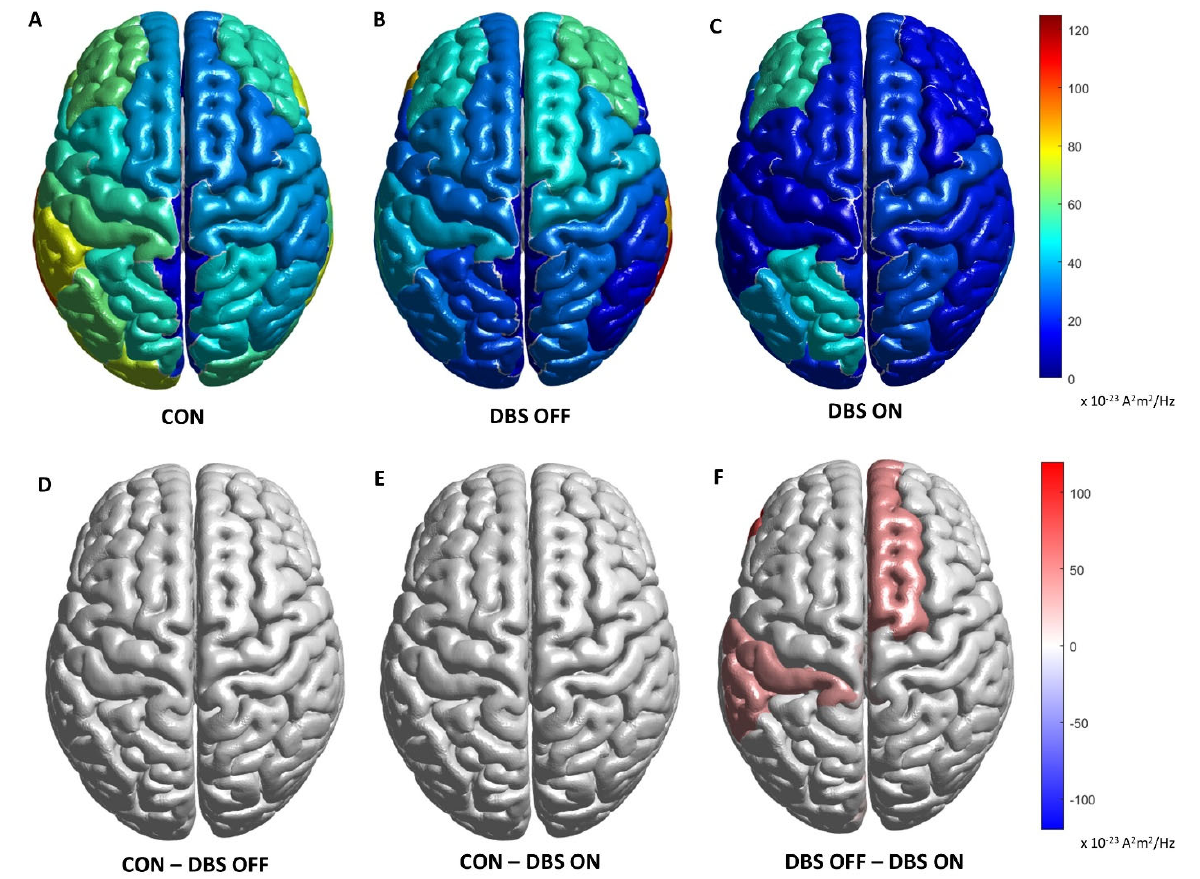
Figure 1. First row shows magnitude of power spectral density for each ROI, respectively, in controls ( A ) and in PD patients with DBS ‐ OFF ( B ) and DBS ‐ ON ( C ) states in β frequency bands. Second row reports differences in magnitudes of power spectral density between controls and PD DBS ‐ OFF ( D ), controls and PD DBS ‐ ON ( E ) and DBS ‐ OFF and DBS ‐ ON states ( F ) in β frequency bands. Only differences with a p < 0.05 are shown. CON: control group. DBS OFF: PD patients in DBS ‐ OFF state. DBS ON: PD patients in DBS ‐ ON state. CON–DBS OFF: difference between controls and PD patient in DBS ‐ OFF state. CON–DBS ON: difference between controls and PD patient in DBS ‐ ON state. DBS OFF–DBS ON: difference between PD patient in DBS ‐ OFF and DBS ‐ ON states.